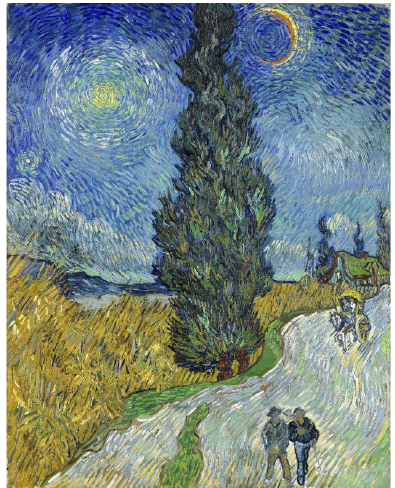
Figure 6. “Country road in Provence by night” by Vincent van Gogh, 1890. Painterly brushstrokes on the road follow its edges, while brushstrokes in the sky are parallel to edges of the star and the crescent.